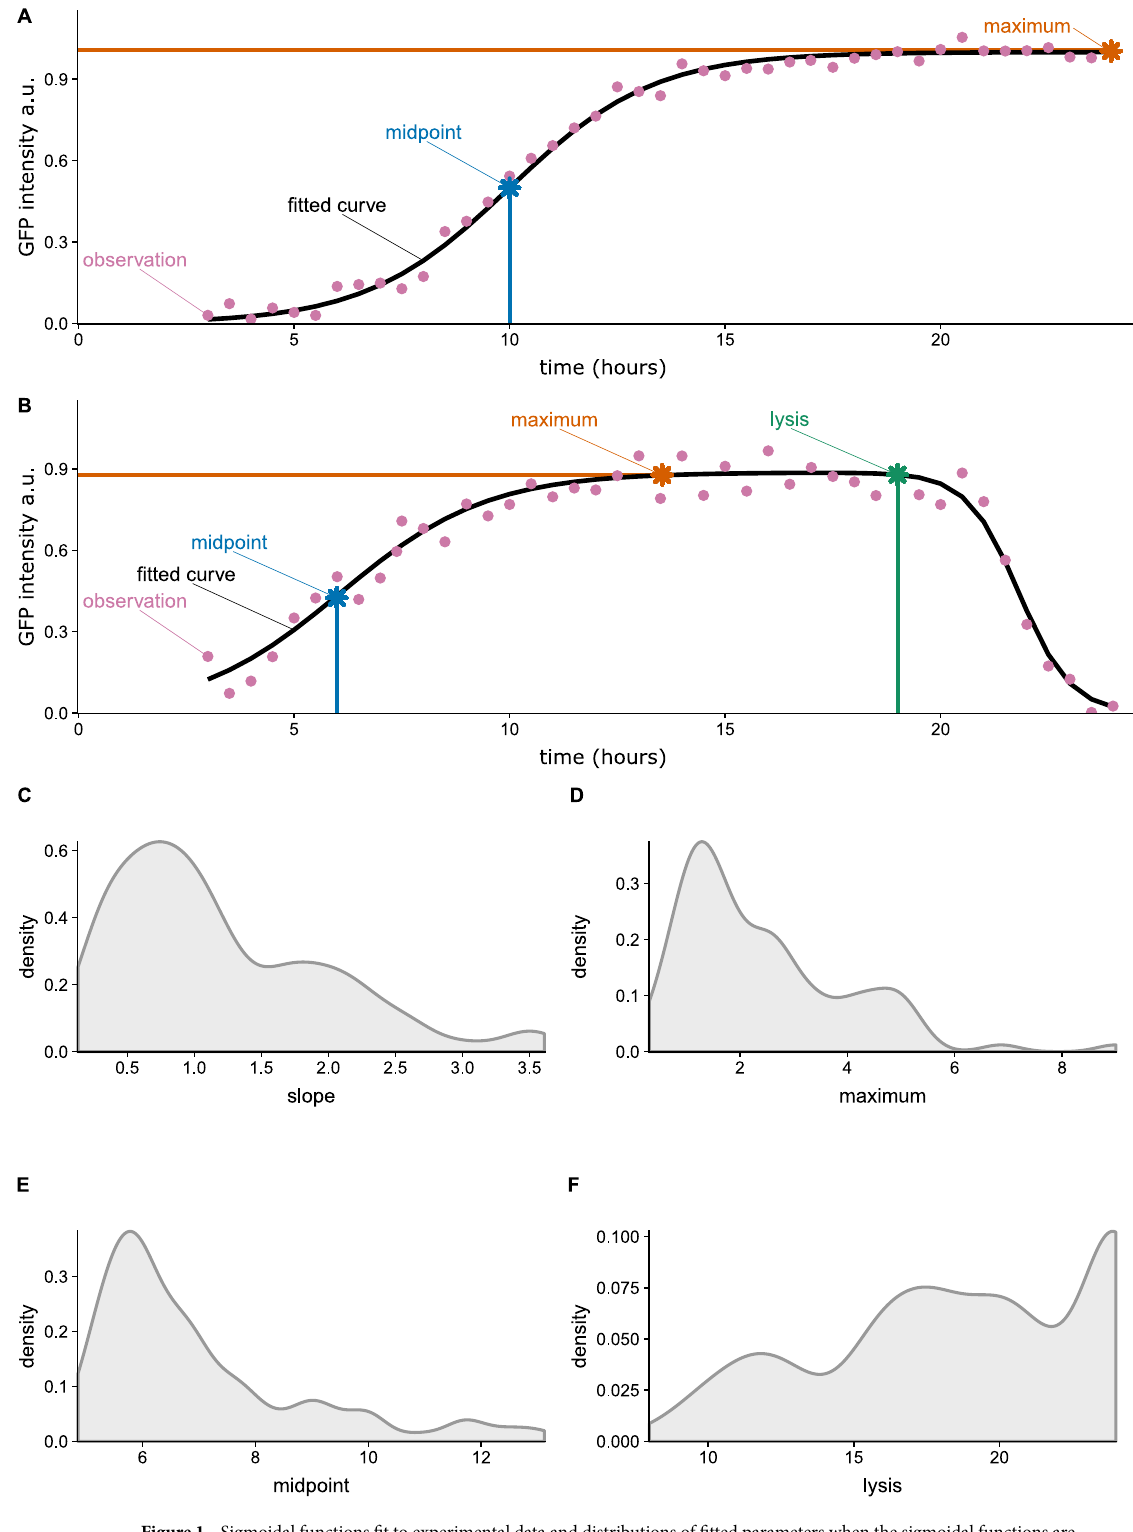
Figure 1. Sigmoidal functions fit to experimental data and distributions of fitted parameters when the sigmoidal functions are fit to a population of infection events generated by Liu et al. 16 without drug treatment. ( A ) Example of sigmoidal function fit to experimentally data of GFP intensity measured in arbitrary units (a.u.). A sigmodal curve (black line) is fitted to intensity observations from a single infection event (purple dots), allowing for the estimation of the midpoint (blue) and the maximum intensity value (orange). ( B ) Example of double-sigmoidal function fit to a single infection event where lysis is observed. A double sigmodal curve (black line) is fitted to intensity observations from a single infection event (purple dots), allowing for the estimation of the midpoint (blue), the maximum intensity value (orange), and the time point of lysis (green). ( C ) Distribution of slopes calculated at the midpoint. The slope is related to the viral replication rate. ( D ) Distribution of the maximum intensity. ( E ) Distribution of the amount of time until the half of the maximum intensity is reached. ( F ) Distribution of the length of infection